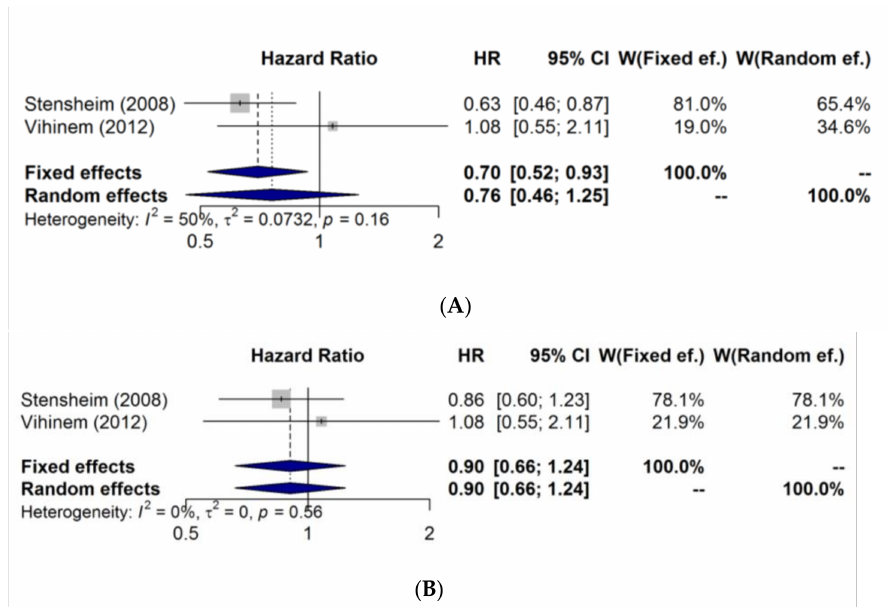
Figure 2. Meta-analysis of melanoma-specific mortality. ( A ) Forest plot showing pooled crude HR (Stensheim’s and Vihinen’s studies) with 95% CI for melanoma-specific death, comparing previous pregnancy or not. ( B ) Forest plot showing pooled crude HR (Vihinen’s) and adjusted HR (Stensheim’s) with 95% CI for melanoma-specific death, comparing previous pregnancy or